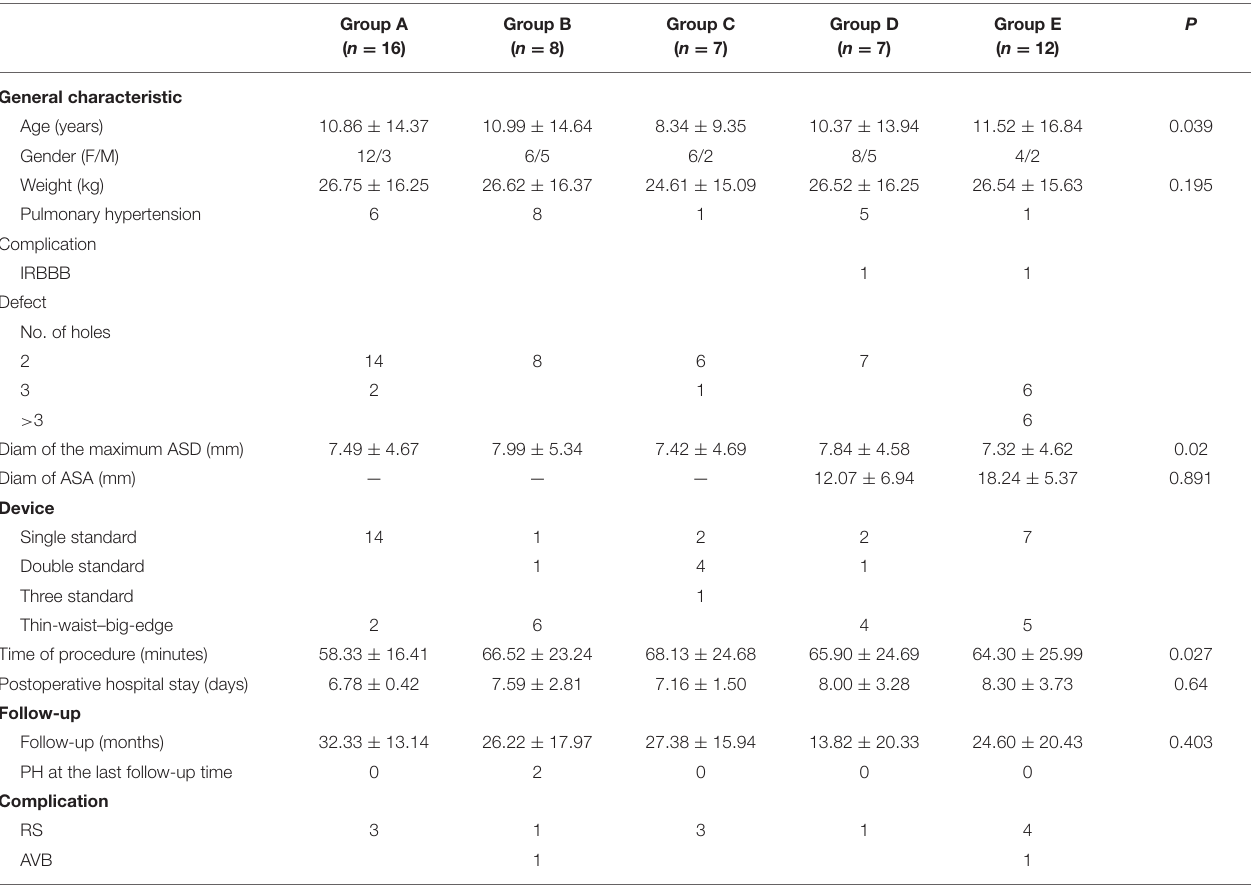
TABLE 1 | The patients’ demographic characteristic